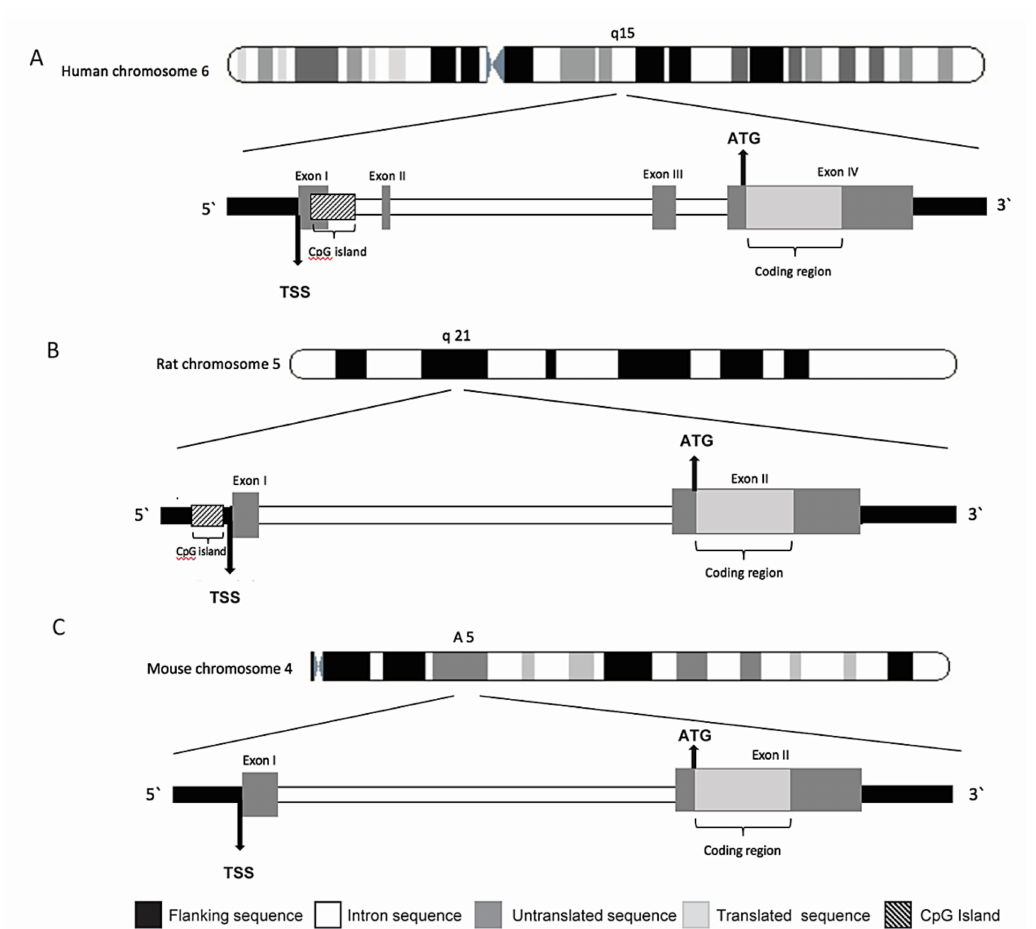
Figure 1. Schematic representation of human( A ), rat ( B ) and mouse ( C ) CNR1 gene, with their cromosomial locations. Also, in mice and rats the coding region of CNR1 is contained within a single